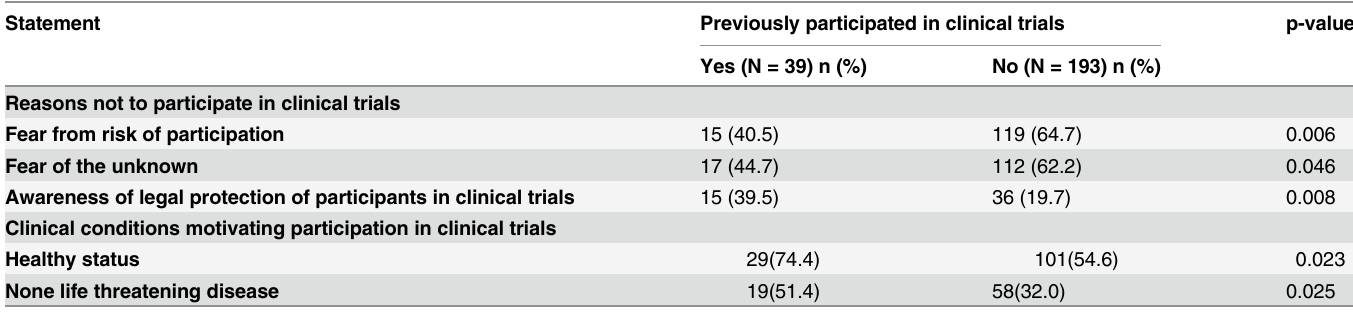
Table 6. Comparison between participants who had previously participated in a CT and those who had never participated in terms of knowledge, attitudes and perceptions towards participating in clinical trials.